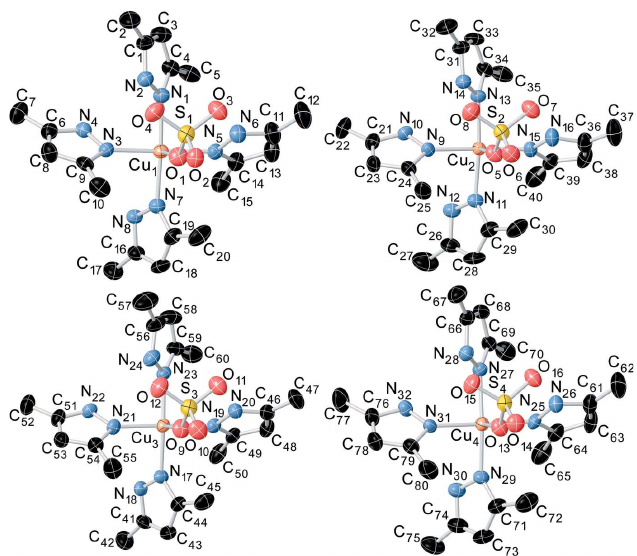
Figure 1 Representation of four [Cu(SO 4 )(Hdmpz) 4 ] formula units in the structure of the title coordination polymer, with displacement ellipsoids at the 50% probability